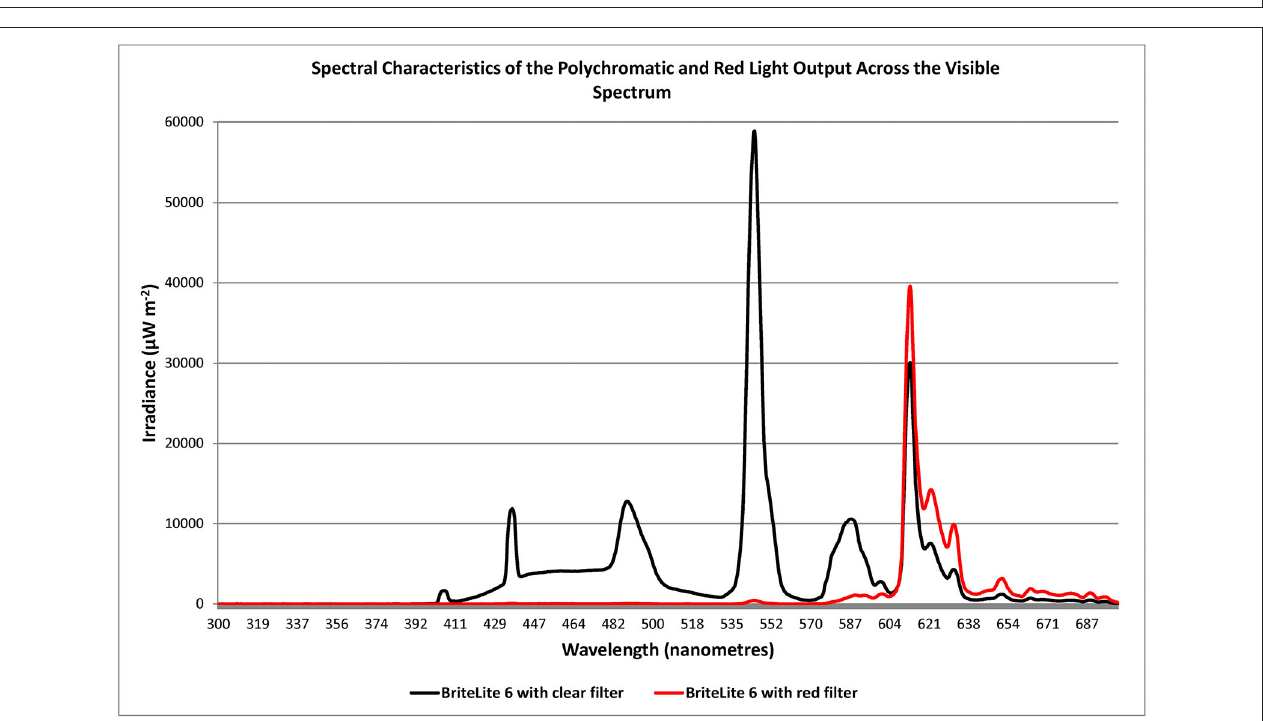
FIGURE 4 | commenced and before patients were randomly assigned to their respective treatment groups. The inclusion bars show significant statistical comparisons with p -values indicating the levels of significance obtained. Statistical comparisons were made between baseline (Pre) and Week 1, Pre and Week 2 and Week 1 and Week 2. Significant levels were determined a priori with p ≤ 0.05 regarded as significant while trends were designated as p -values ranging from 0.051 to 0.099. The star represents a significant overall effect using the Friedman’s Two Way ANOVA while the inclusion bars mark significant comparisons using the Wilcoxon Signed Rank Test.